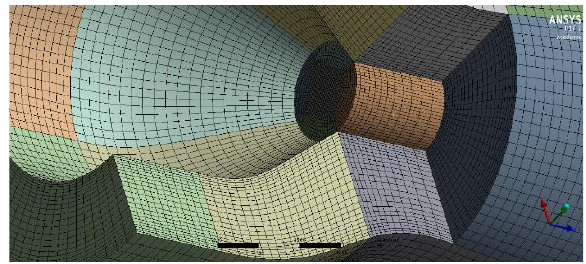
Fig. 7. Computational mesh close to the swirl generator cone